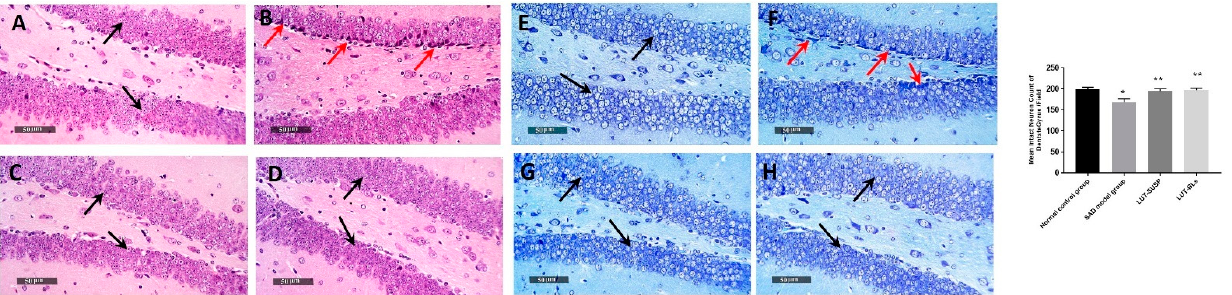
Figure 10. Neuroprotective histopathological effect of different treatments on dentate gyrus/hippocampal subregions of AD model stained with H&E stain. ( A ) Normal controls, ( B ) model AD samples, ( C ) LUT suspension samples, and ( D ) LUT-BL samples. Microscopic examination of toluidine-blue-stained pyramidal neurons in dentate gyrus/hippocampal subregions in different groups. ( E ) Normal controls, ( F ) model AD samples, ( G ) LUT suspension samples, and (H) LUT-BL samples. Black arrows = intact neurons, red arrows = damaged neurons. * statistically significant difference from normal control group and ** statistically significant difference from the SAD model group.